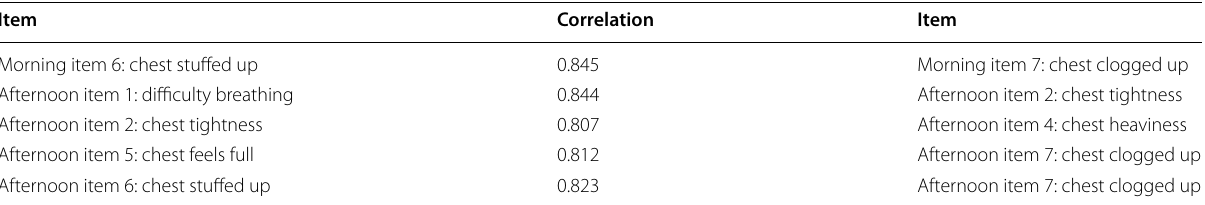
Table 3 Summary of inter-item correlations >